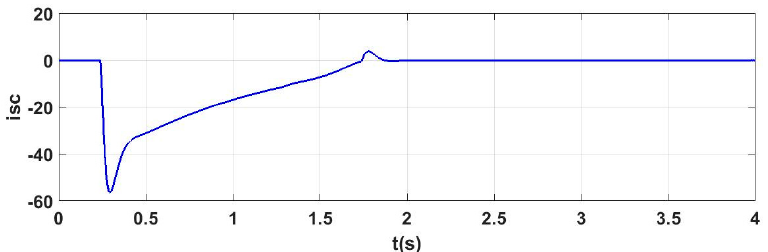
Figure 14. Output current (cid:1835) (cid:3039)(cid:2870) f or (cid:2028) = 0.5 s.